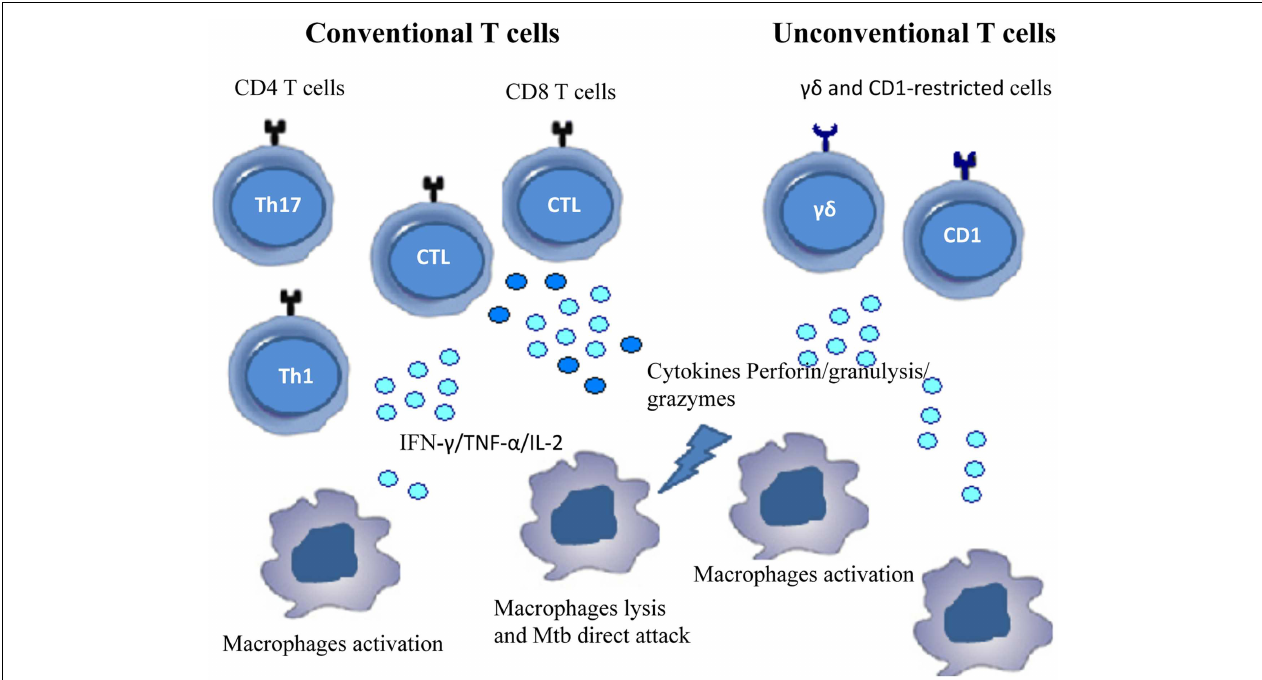
FIGURE 1 | Cells involved in immune response during Mtb infection .The figure shows conventional and unconventionalT cell subsets that contribute to the immune response against